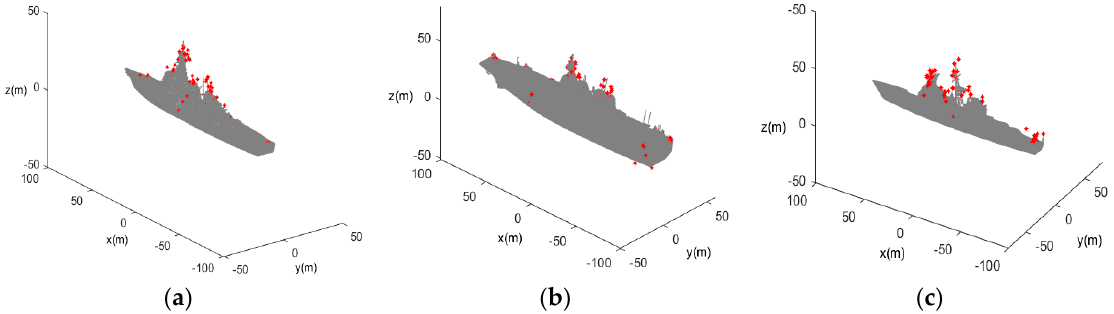
Figure 2. Target CAD models and the corresponding 3D scattering center models (3D-SCMs): ( a ) Target Class A; ( b ) Target Class B; ( c ) Target Class C.